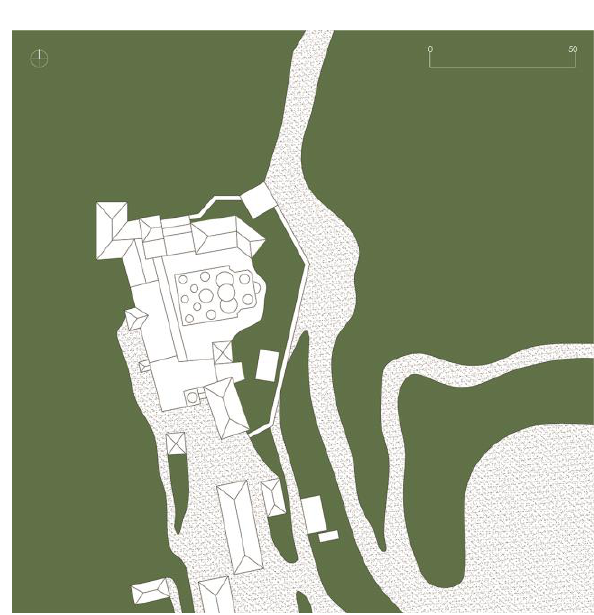
Figure 18 . The Monastery of Simonpetra. Planimetry of the hypogeum and planimetry ground floor.